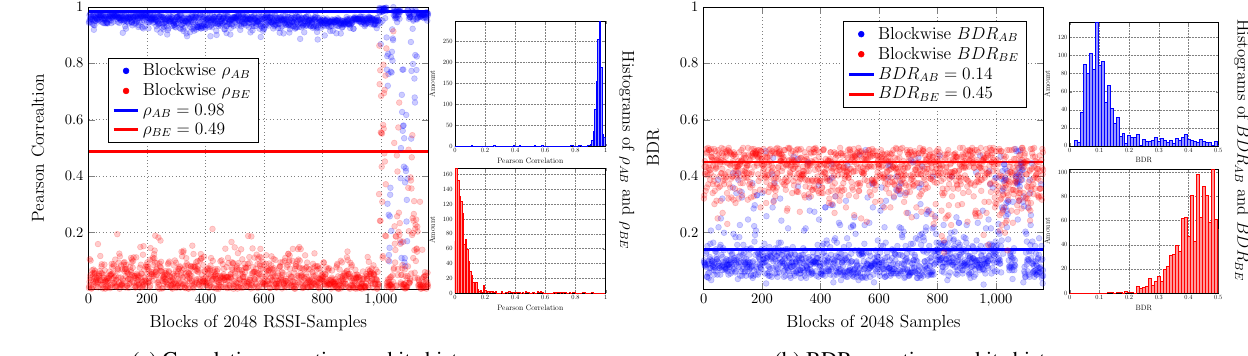
Figure 5: Evaluation results for: (a) correlation coefficient over time. Alice and Bob with strong correlated signals. After block 1000 , the motion of the measurement platform stopped, with the result of low correlation. Eve and Bob achieve weak correlated signals. (b) BDR over time, applying ASBG-multibit quantization [10]. Alice and Bob with relatively low BDR; Eve and Bob with BDR around 0 . 5 .